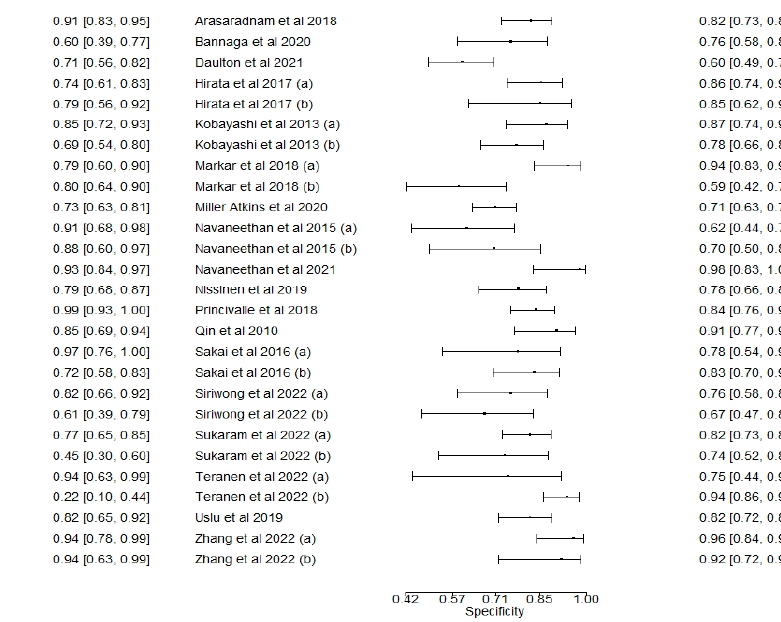
Figure 3. Summary receiver operator curve characteristics for volatile organic compounds in the detection of hepatobiliary and pancreatic cancer. The circle represents the con fi dence interval, and the dots represent the distribution of studies.